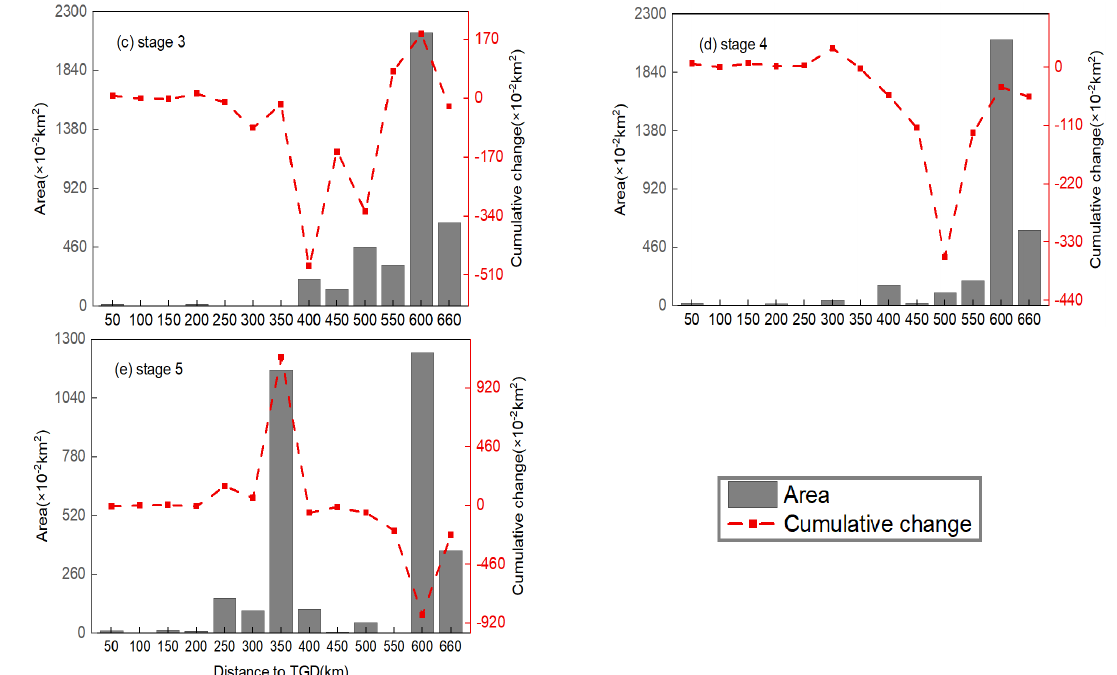
Figure 8. Spatial distribution and changes in the area of MCBs in different impoundment periods: ( a ) stage 1, ( b ) stage 2, ( c ) stage 3, ( d ) stage 4 and ( e ) stage 5.